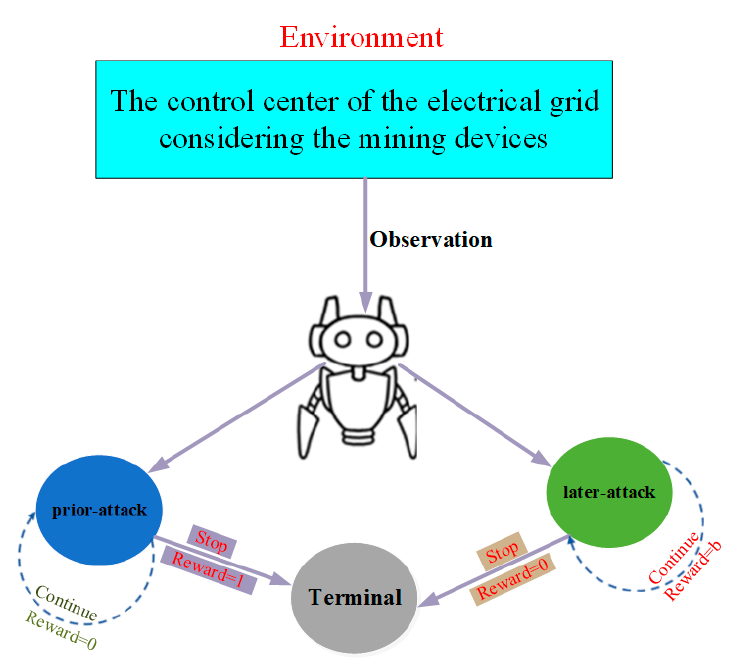
Figure 3. The anomaly detection